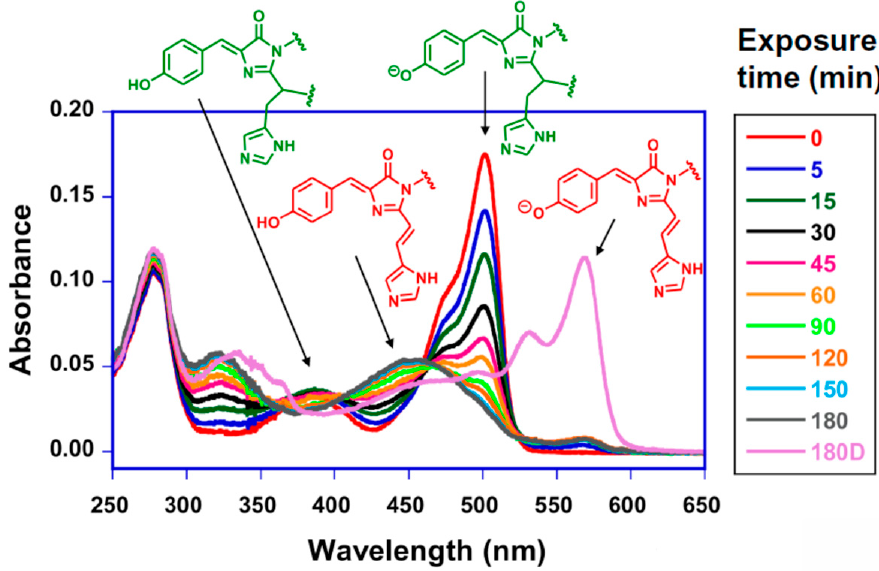
Figure 1. Timecourse of photoconversion of the pcFP least evolved ancestor (LEA). Experiments were carried out at pH 5.7 with 405 nm LED illumination [13]. The exposure times (0 to 180 min) are listed in the box. After 180 min exposure, the sample was dark-adapted overnight (180D), providing evidence for a slow conformational relaxation step that favors the anionic chromophore. The respective maxima for green and red chromophores in their neutral and anionic states are indicated, and the chemical structures of these chromophores are shown in green and red.